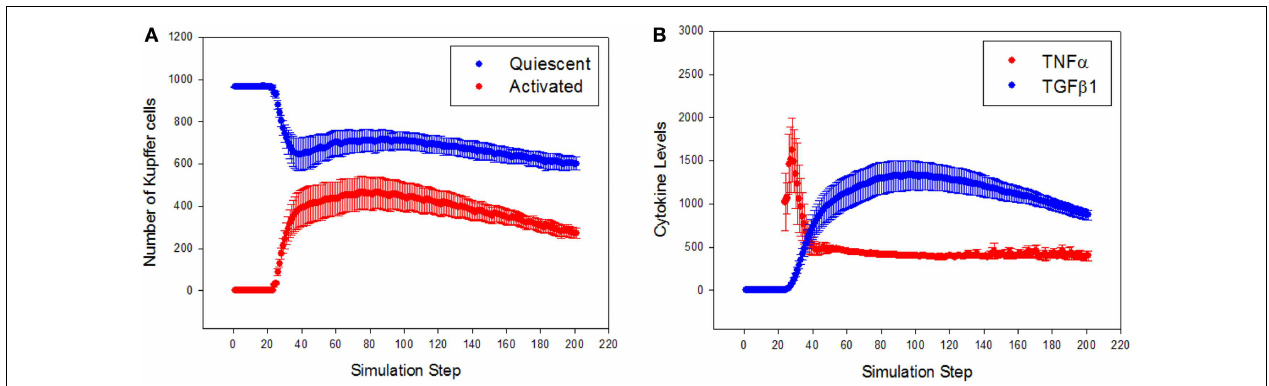
(red) andTGF- β 1 (blue) as inflammation progresses. Activated Kupffer cells are at first dominated by an M1 phenotype, as demonstrated by the early peak of